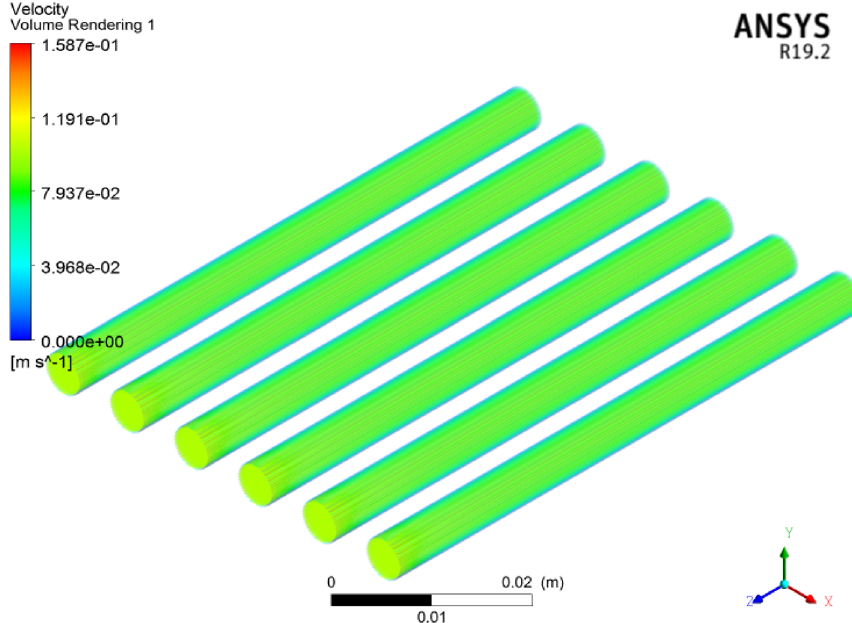
Figure 7. Cross-sectional view of velocity in microchannels by ANSYS.